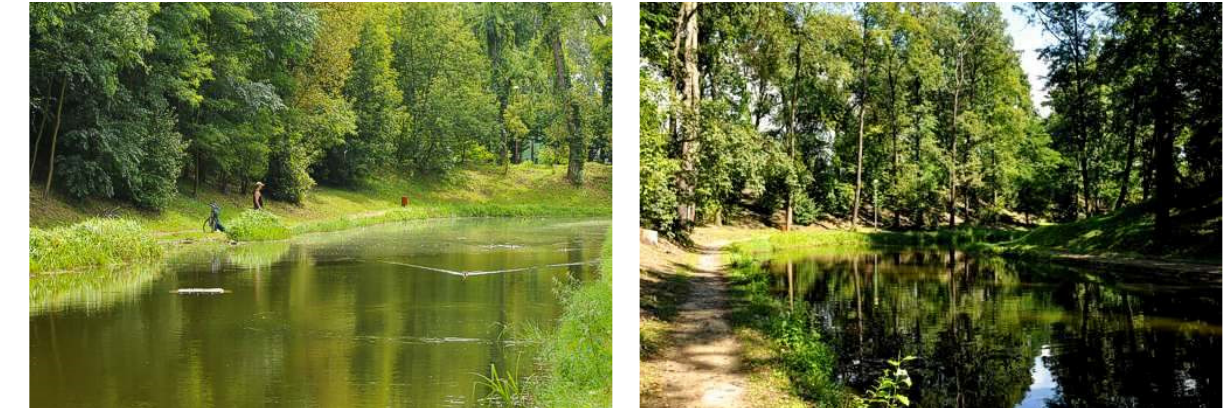
Figure A12. Above the Fort Bema ditch in midsummer—path across the moat (source: own).